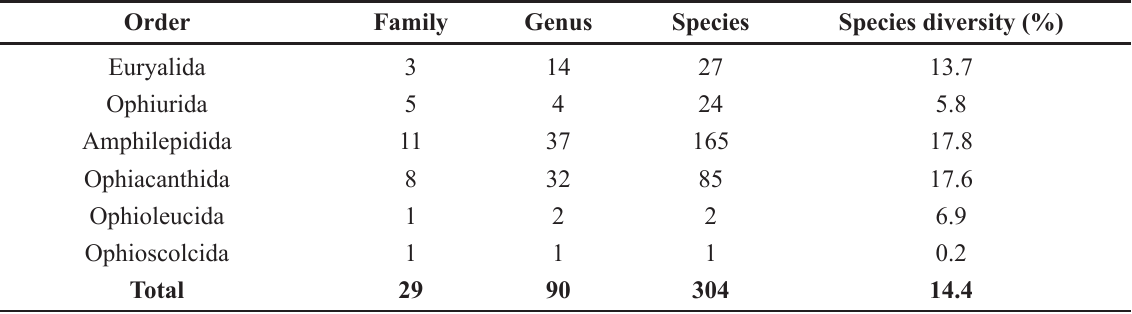
Table 3. Species diversity in all six current orders of Ophiuroidea in the South China Sea (sources: Lane et al. 2000; Liao 2004; Putchakarn & Sonchaeng 2004; Sirenko et al. 2019; Chen et al. 2020; Li et al. 2021). Note: some species were removed due to uncertainty of location, especially near Philippine seas; see Lane et al.